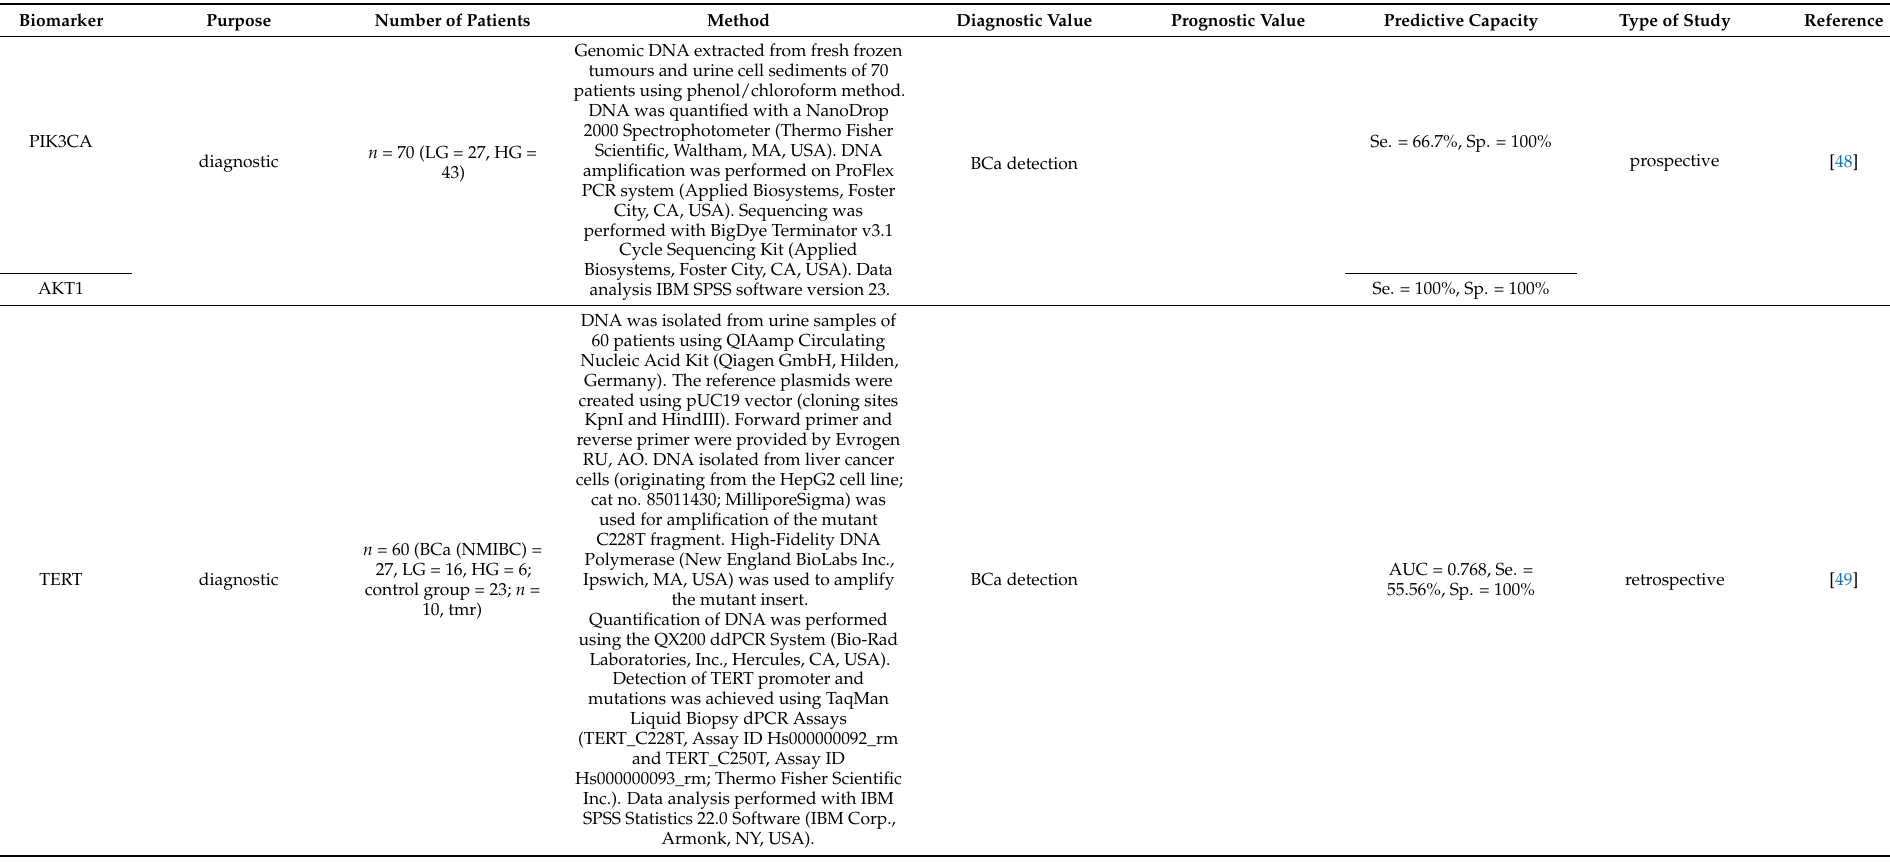
Table 5. Table presenting data for mutations